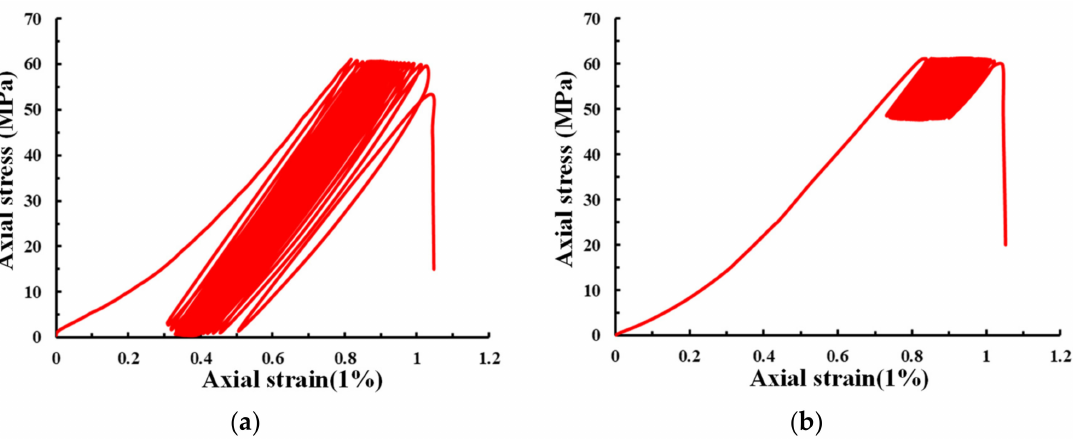
Figure 9. Fatigue stress–strain curves of sandstone samples at different lower limit stresses. ( a ) Sample F1-1; ( b ) Sample